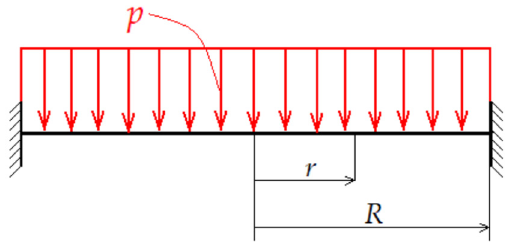
Figure 6. Functionally graded circular plane plate. The material properties are presented in Table